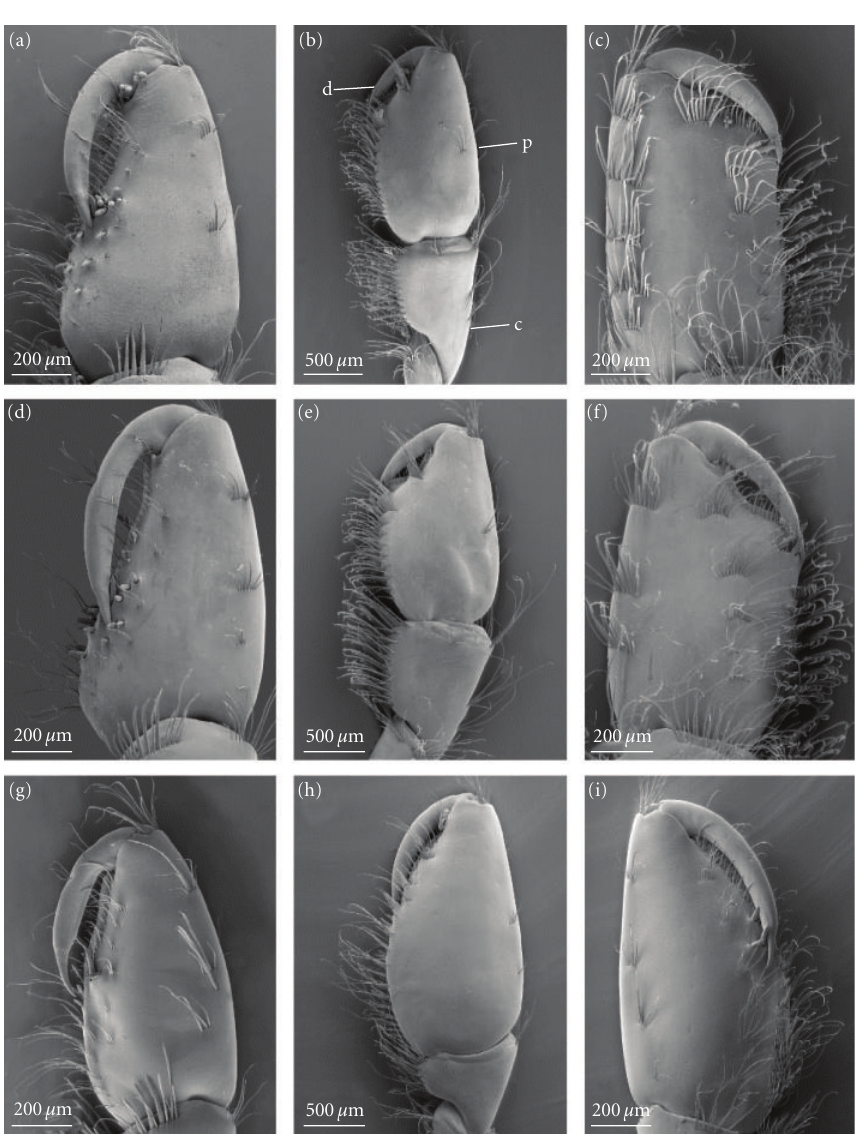
Figure 4: SEM images of distal part of gnathopods: (a) right first gnathopod of G. pulex in anterior view; (b) left second gnathopod of G. pulex in posterior view; (c) left second gnathopod of G. pulex in anterior view; (d) right first gnathopod of G. fossarum in anterior view; (e) left second gnathopod of G. fossarum in posterior view; (f) left second gnathopod of G. fossarum in anterior view; (g) right first gnathopod of E. berilloni in anterior view; (h) left second gnathopod of E. berilloni in posterior view; (i) left second gnathopod of E. berilloni in anterior view. Abbreviations other than in previous figures: c: carpus; d: dactylus; p: